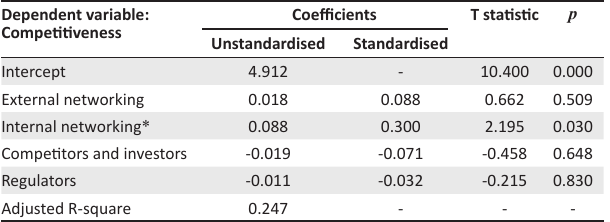
TABLE 7: Regression analysis (competitiveness versus stakeholder variables relating to SMTs). Dependent variable: